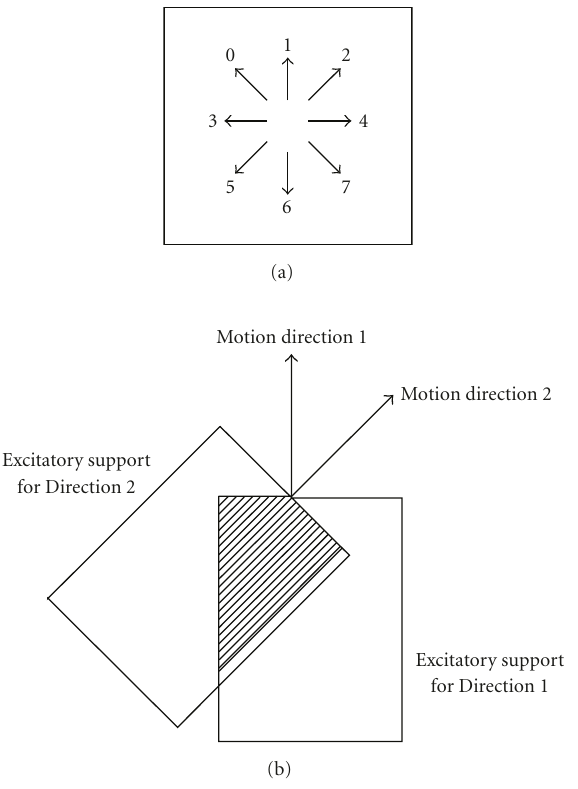
Figure 1: (a) Quantized motion directions separated by angle pi/ 4, (b) direction 1 neighborhood in “up” direction, direction 2 neigh- borhood in “shown angled”